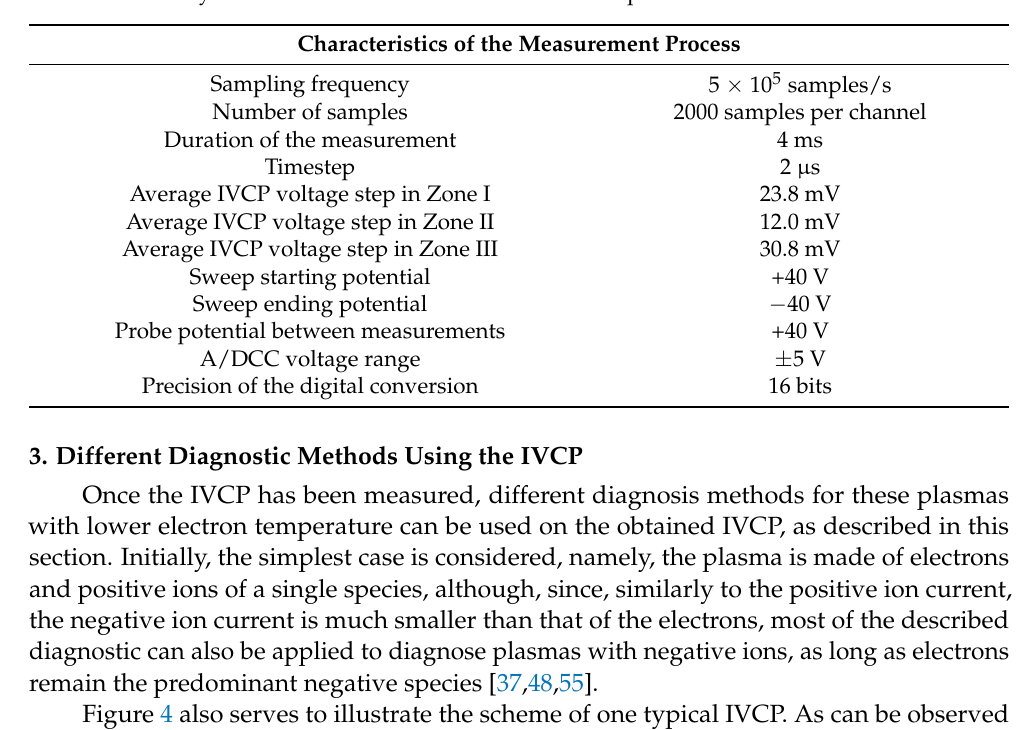
Table 1. Summary of the characteristics of the measurement